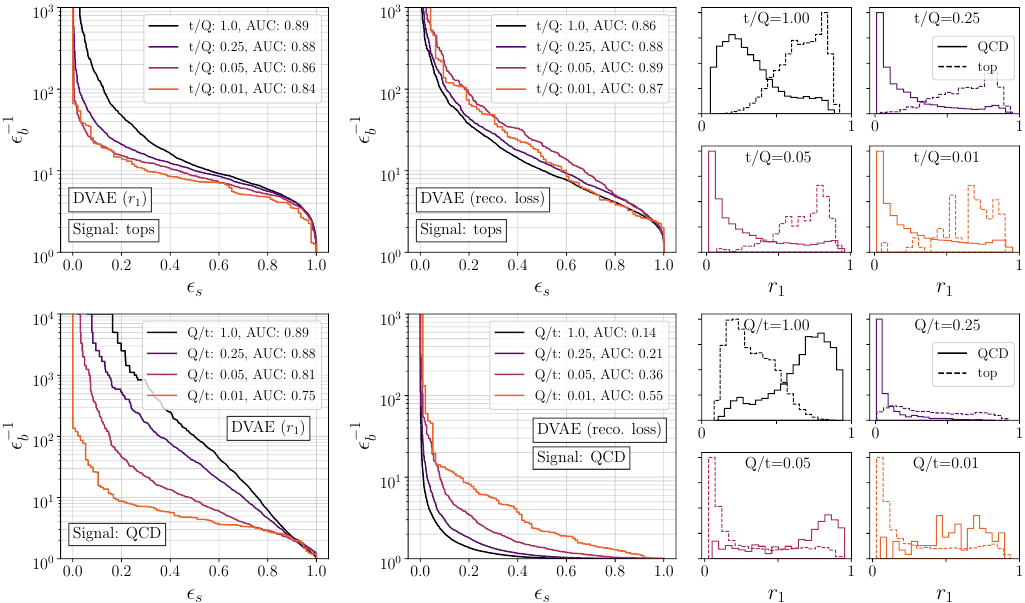
Figure 9: DVAE results for various amounts of anomalous top (upper) and QCD (lower) jets in the sample, where the mixture weights (left) and the reconstruction loss (middle) are used for classification. In the small panels we show the distributions of the top and QCD jets in the latent